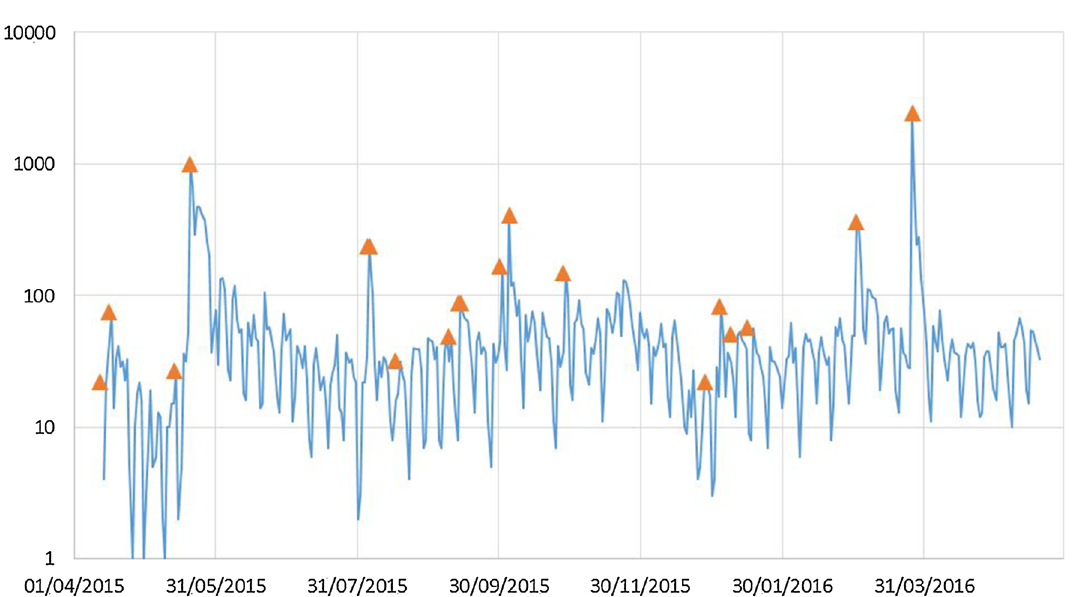
Fig. 5 Time history of the number of sessions at the #italiasicura website, 1 April 2015 to 20 May 2016, and the flood events (yellow triangles) that were correlated with the session peaks. The y-scale is logarithmic